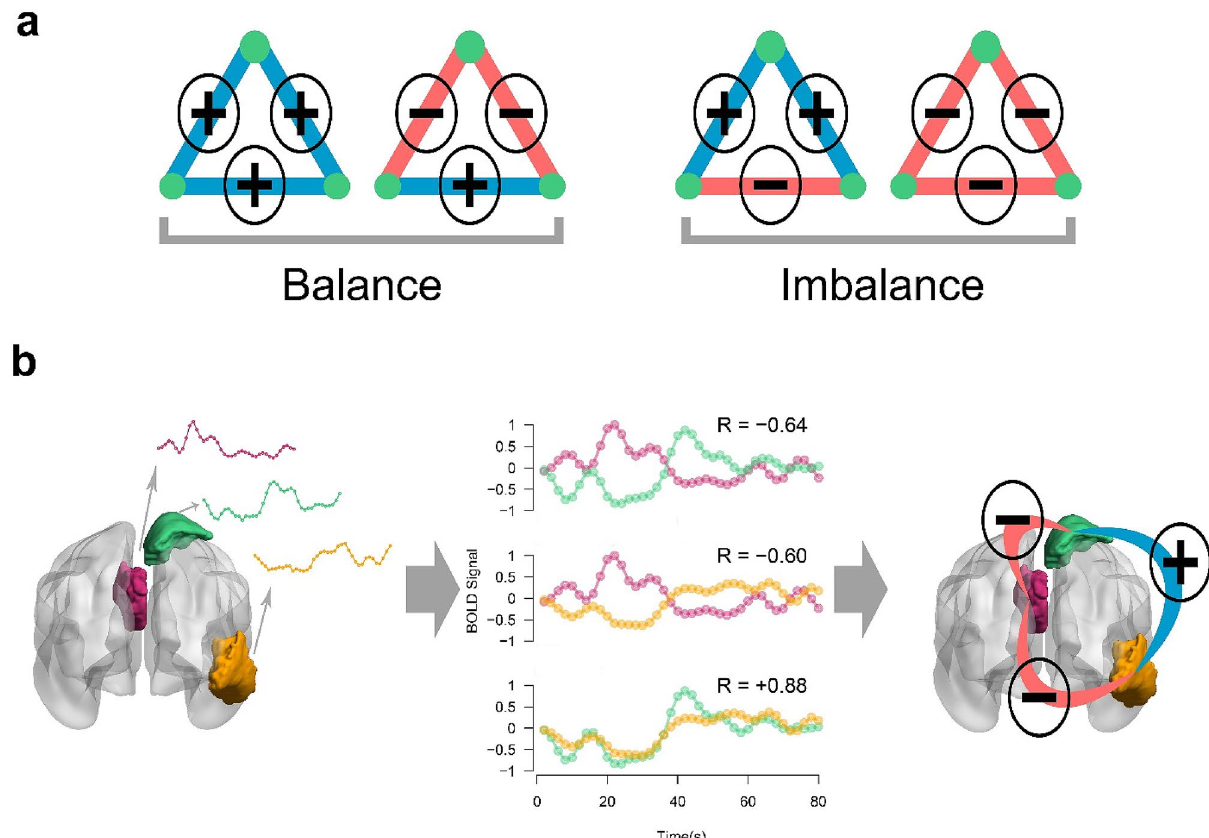
Figure 1. Triadic associations in balance theory. (a) Possible triad types of a signed network. Blue and red colors denote positive and negative links. (b) Formation of a triadic relation in the brain. Activity pattern of three brain regions (left) correlate together (middle) and build a balanced triangle (right). The selected regions of interest are colored violet, green, and orange that belong to Default Mode Network, Dorsal Attention Network, and Visual network of the brain, respectively. R Pearson correlation